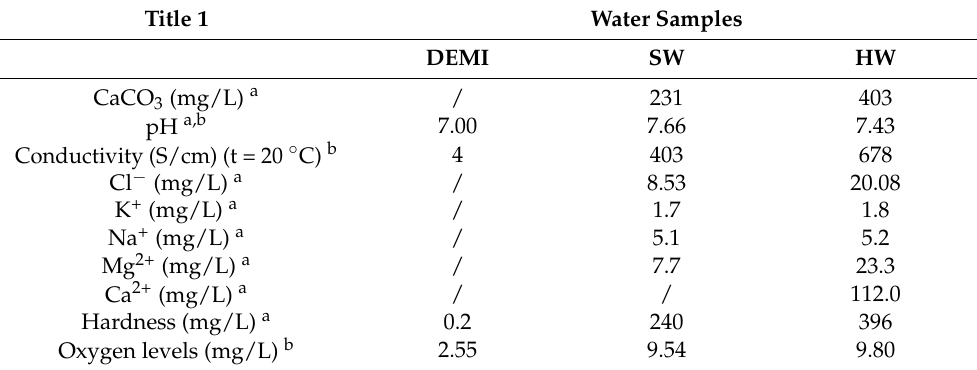
Table 1. General properties of the water samples used in this work. Soft water (SW) and hard water (HW) were taken from water wells in Nedeliš´ce and Prelog in Me ¯dimurska County